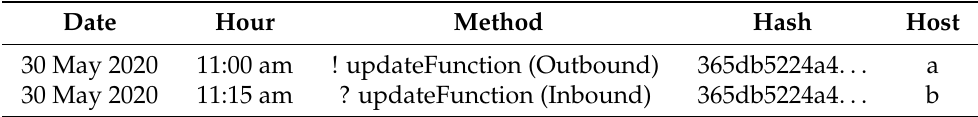
Table 2. Normal entries in the log of the client application.